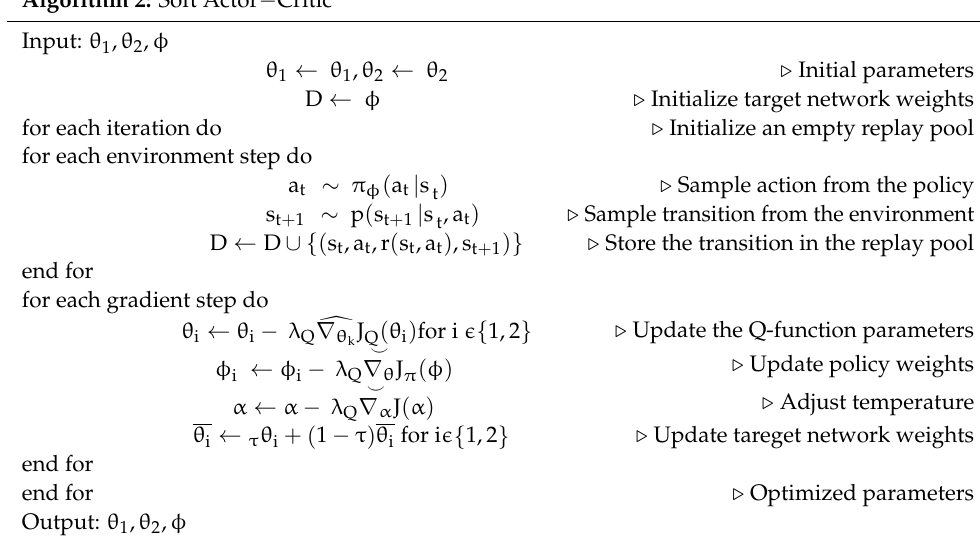
Algorithm 2: Soft Actor −